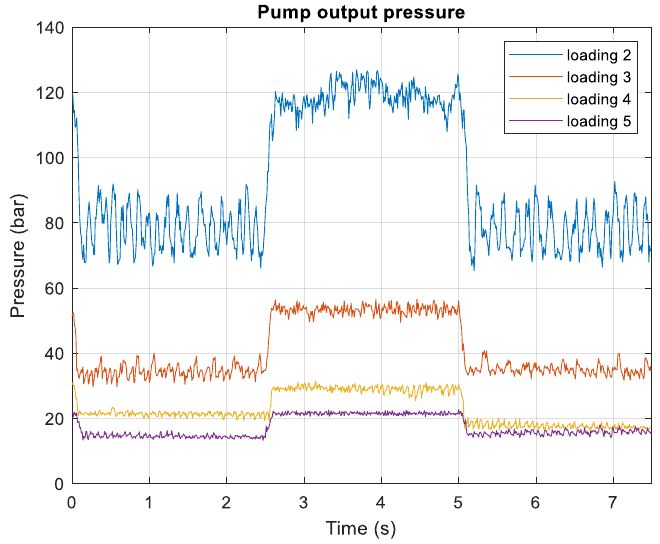
Figure 19. Comparison of pump output pressure for different loading conditions.